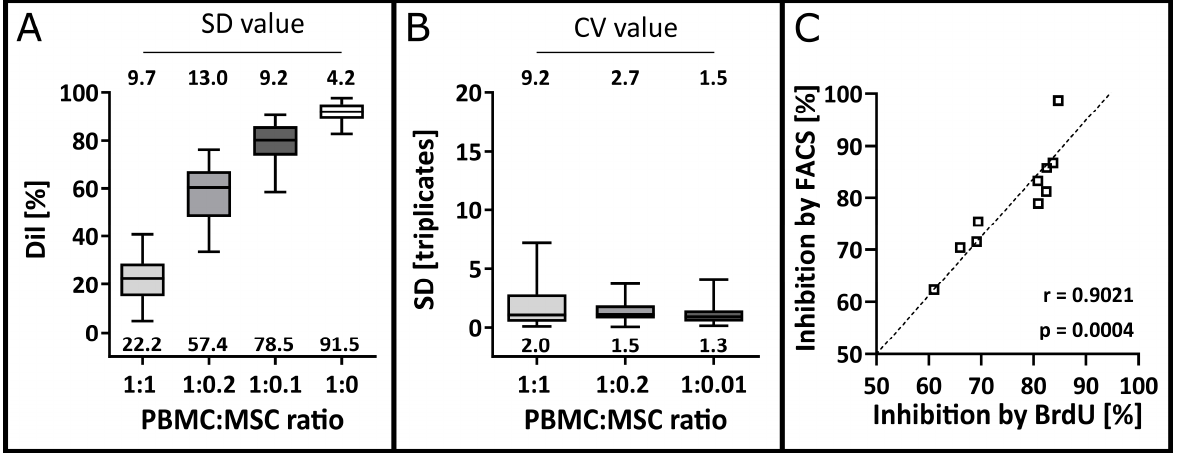
Figure 5. Precision and accuracy. ( A ) The intermediate precision was determined by plotting the mean Dil values of each triplicate for n = 30 MLRs. Overall mean values are indicated below the box plots of the 90% confidence interval. The overall SD values were determined as validation parameters and are indicated above the box plots. ( B ) The repeatability or intra-assay precision was determined by analysing the SD for each triplicate measurement for each PBMC:MSC ratio. Mean SD values are indicated below the box plots of the 90% confidence interval. The CV was analysed for each triplicate as a validation parameter, and the respective mean values are indicated above the box plots ( n = 30). ( C ) Accuracy of T cell inhibition using the FACS-based MLR in comparison to the BrdU-MLR. Inhibition values measured with FACS and with BrdU were plotted against each other. The degree of linear correlation was computed using the Pearson correlation coefficient with α = 0.05 resulting in r = 0.9021 and p = 0.0004.